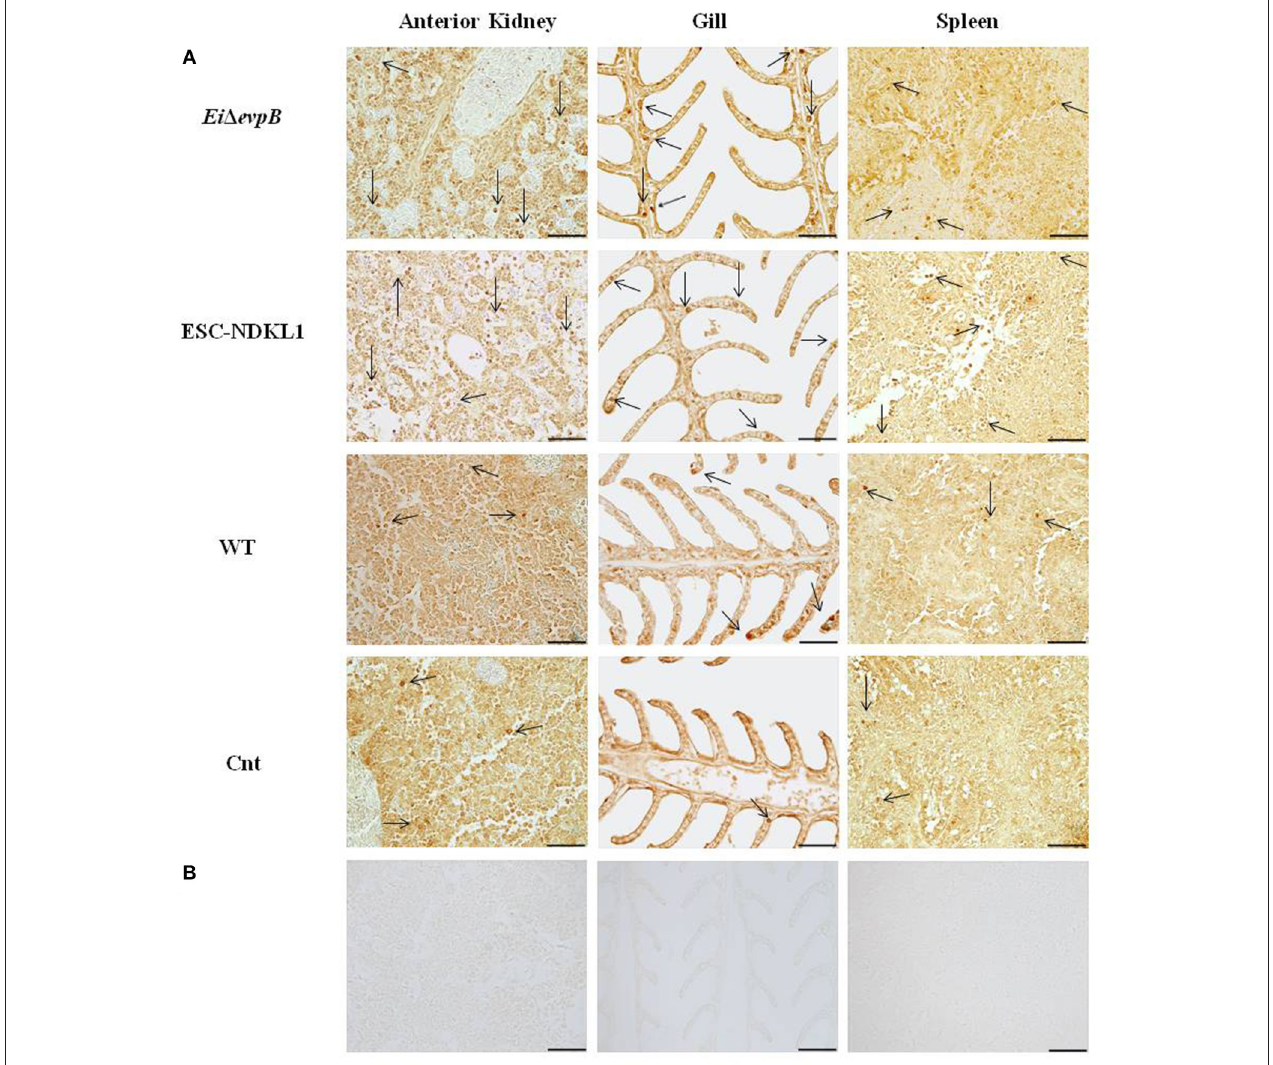
FIGURE 1 | Identification of L/CD207 + cells by IHC in the lymphoid organs (AK, spleen) and gills of channel catfish challenged with E. ictaluri LAV and WT strains. The left column shows the L/CD207 + specific (A) and background staining (B) in AK of catfish in all groups at 3 d pc. Middle column indicates the L/CD207 + specific (A) and background staining (B) in the gill at 3 d pc. The right column shows the L/CD207 + specific (A) and background (B) staining in the spleen at 7 d pc. The arrows indicate L/CD207 + cells in the immune-related organs. Photomicrographs (400 x magnification, scale bar 50mm).